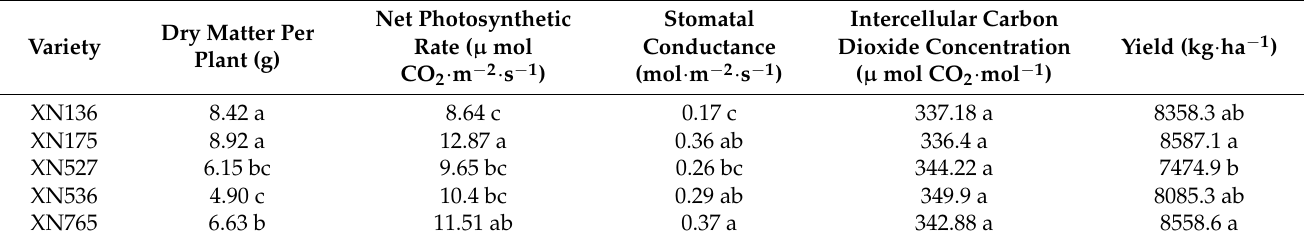
Table 2. Differences in dry matter, photosynthetic characteristics, and final yield of different wheat varieties during grain filling stage from 2021 to 2022. ( p ≤ 0.05, significant difference when the outline and inline characters of the same variety are completely different; p > 0.05, no significant difference when the same or more letters are used).